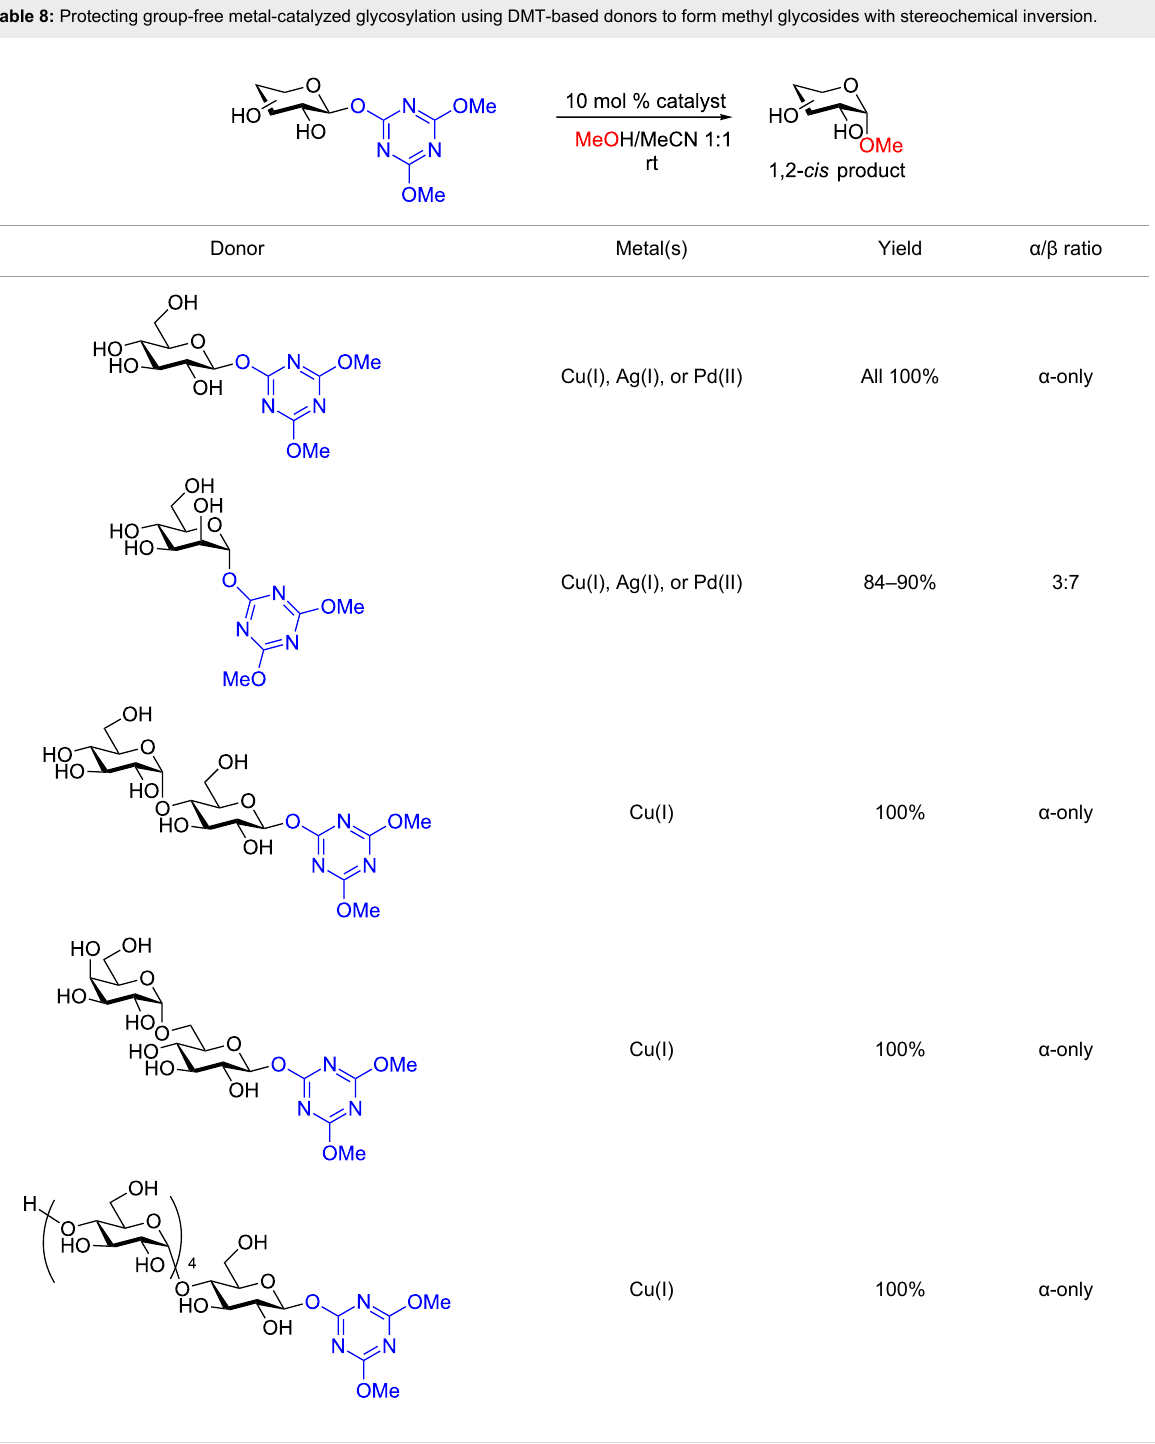
Table 8: Protecting group-free metal-catalyzed glycosylation using DMT-based donors to form methyl glycosides with stereochemical